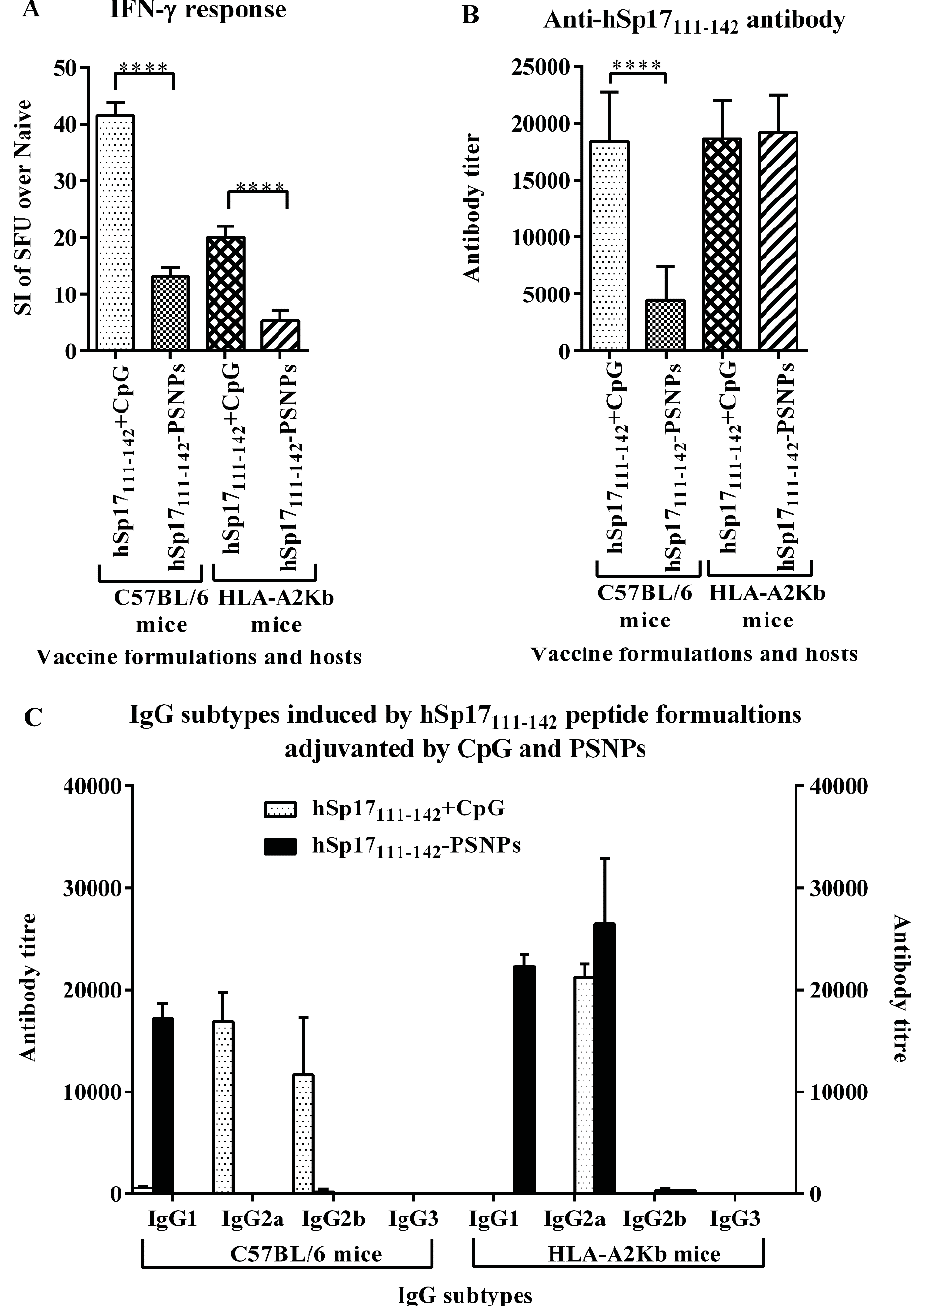
Figure 3. Immunogenicity of the hSp17 111–142 adjuvanted by CpG or PSNPs in different mice strains. C57BL/6 mice ( n = 4/group) and HLA-A2K b mice ( n = 4/group) were immunised 4 times (intradermally at the base of tail, 10 days apart) with hSp17F 111–142 peptide (56 (cid:3)g/mouse), adjuvanted with either CpG (20 (cid:3)g/mouse) or PSNPs (1% solid). 8 days after last immunisation, splenocytes IFN-(cid:2) responses to the peptide antigen were measured by ELISPOT assays. Sera were collected and assayed for antigen specific antibodies by ELISA. ( A ): IFN-(cid:2) responses. Data presented as average SI ± SD (SI = SFU of the peptide response in vaccinated mice/SFU for the same peptide response in naive mice). ( B ): Anti-hSp17 111–142 specific antibody (IgG) production. **** p < 0.0001. ( C ): IgG subtypes in C57BL/6 and HLA-A2Kb mice. Data presented as antibody titres ± SD ( n = 4 individual